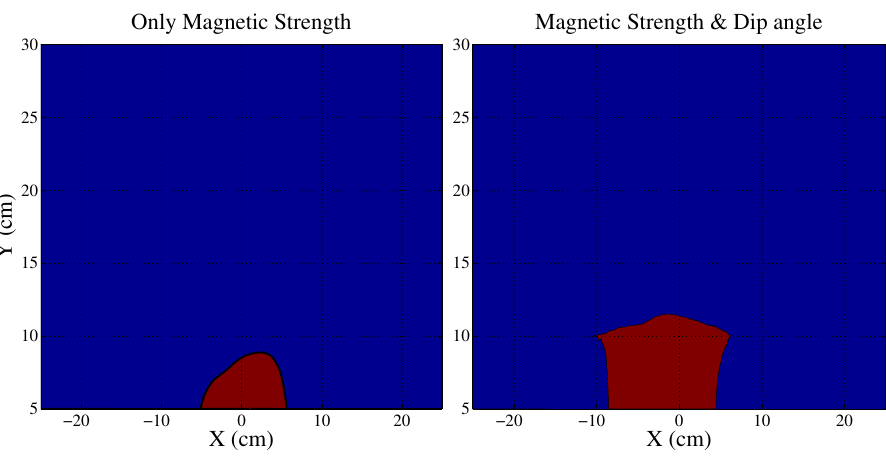
Figure 5. Contour plot showing the areas that are detected as magnetically distorted using magnetic field strength only ( left ) and magnetic field strength and dip angle ( right